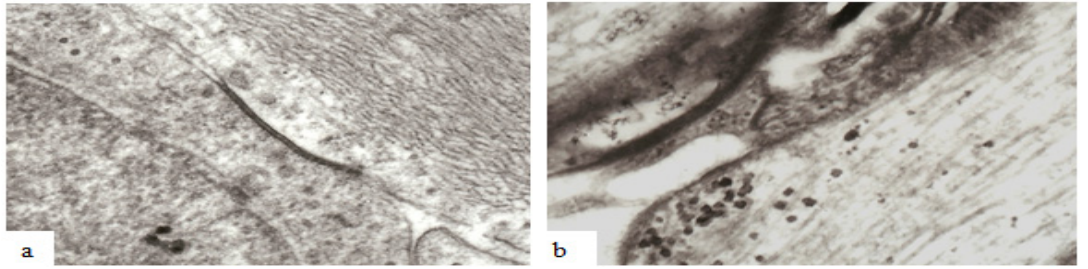
Figure 11. Examples of the ultrastructure of gap junctions between ( a ) astrocytes and ( b ) oligodendrocytes within the mammalian CNS. A gap junction appears as an electron dense apposition of neighboring cell membranes between two cells. Apposed surfaces of adjacent cell membranes are interconnected by connexon proteins forming molecular channels allowing passage of molecules/ions of less than 1000 Da between cells. Magnification